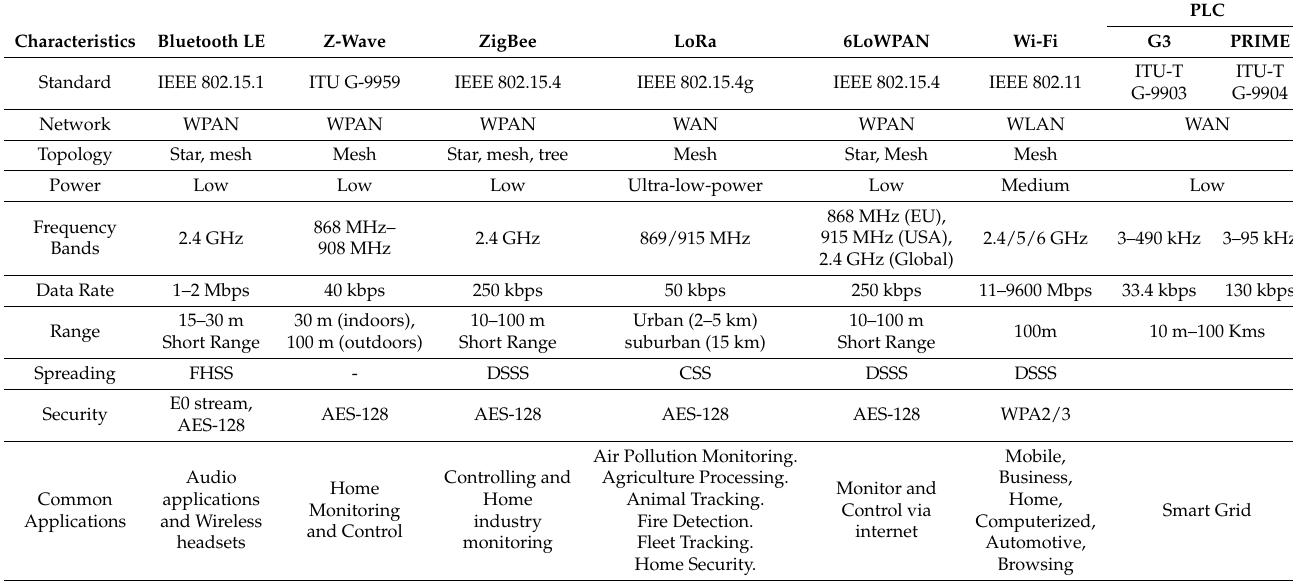
Table 5. Summary of IoT